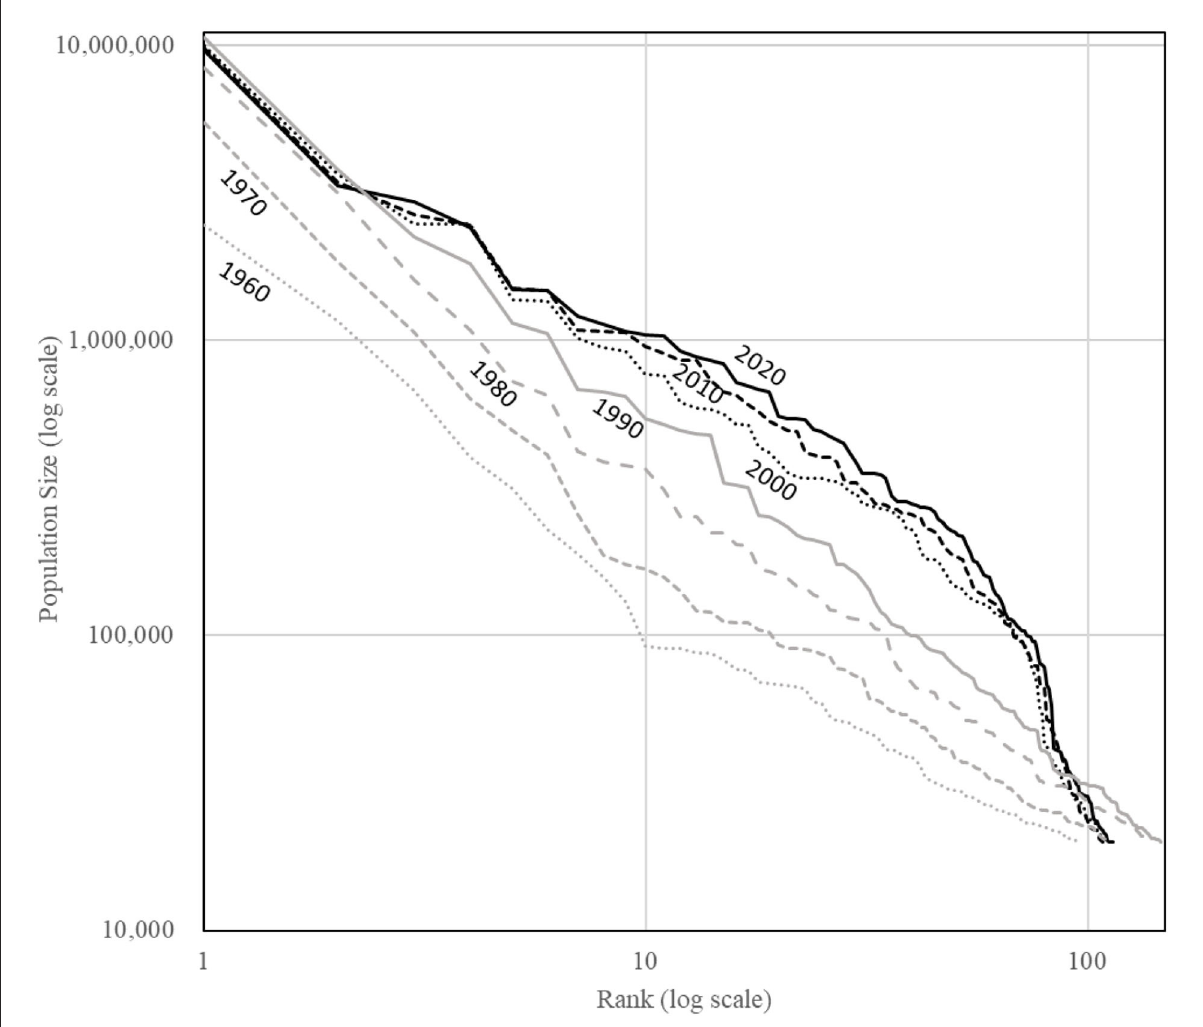
FIGURE3 Rank-size distribution of Korean